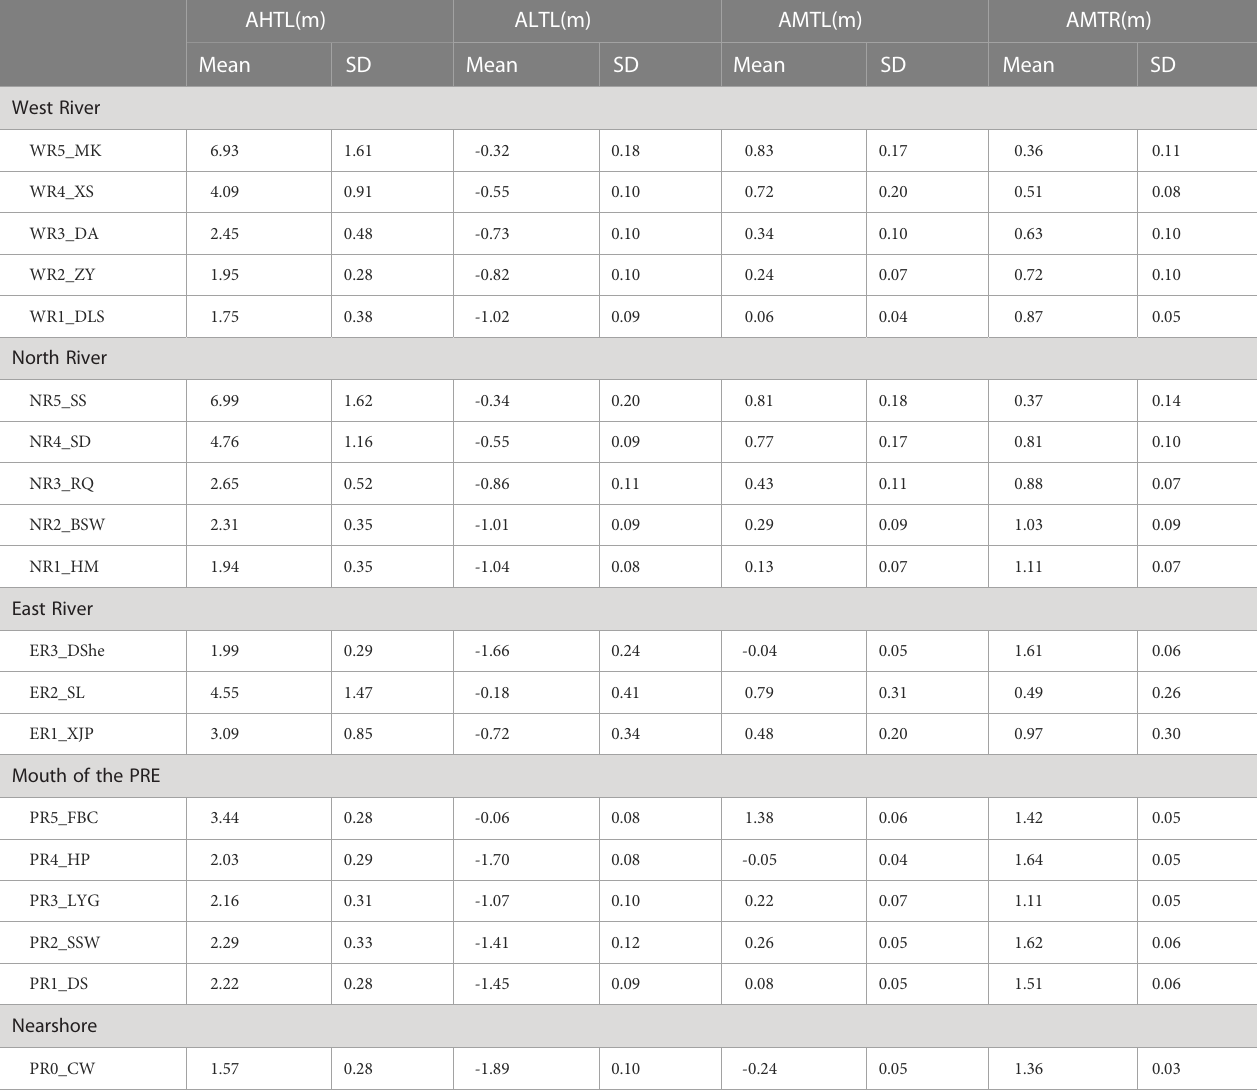
TABLE 2 Mean values and standard deviations (SDs) of the tidal currents and tidal ranges at 20 hydrological stations in